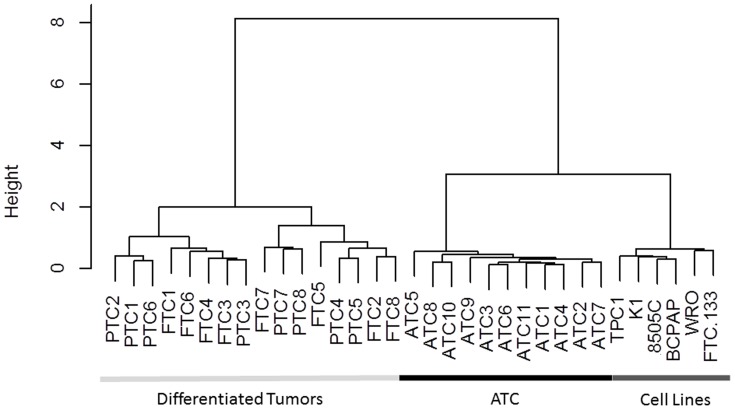
Hierarchical clustering of the microarray data from the 6 cell lines and from different malignant thyroid tumors (PTC, FTC and ATC).Hierarchical clustering was generated using R 2.14.1. The method used to compute the distance was “Ward”. All the cell lines clustered together, with the ATC showing that the cell lines are closest to the dedifferentiated tumors than the tumors from which they derived. The data from the six cell lines were the mean of triplicate experiments. Differentiated tumors refer to papillary (PTC) and follicular (FTC) thyroid carcinomas.